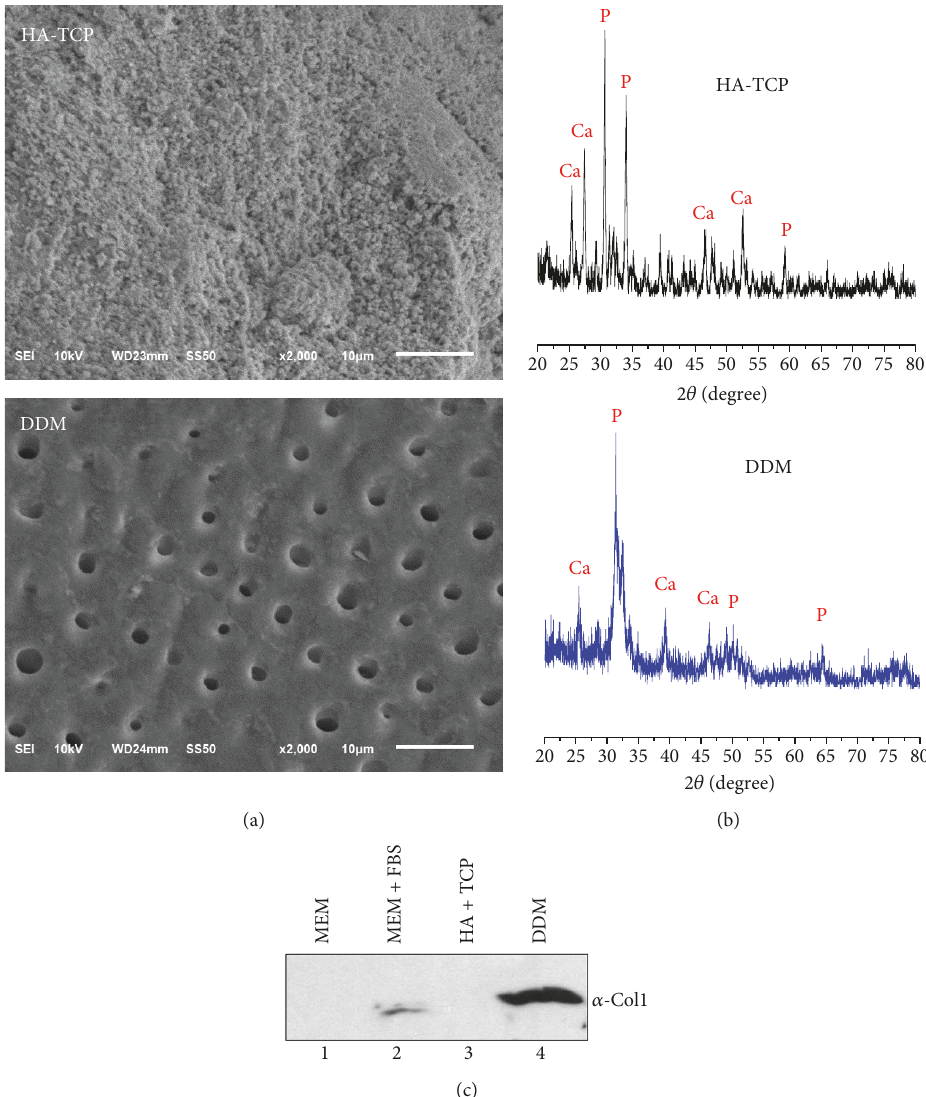
Figure 1: Characteristics of HA-TCP and human DDM sca ff olds. (a) Surface structures of HA-TCP (upper panel) and DDM (lower panel) were examined by SEMs. Scale bars: 10 μ m. (b) X-ray di ff raction patterns of HA-TCP (upper graph) and DDM (lower graph). (c) Analysis of protein components in materials by immunoblot. The extracts of HA-TCP and DDM granules were concentrated, separated on SDS-PAGE, and immunoblotted with anti-type-1 collagen antibody. 1, α -MEM only; 2, α -MEM with 10% FBS; 3, HA-TCP extract in α -MEM; 4, DDM extract in α